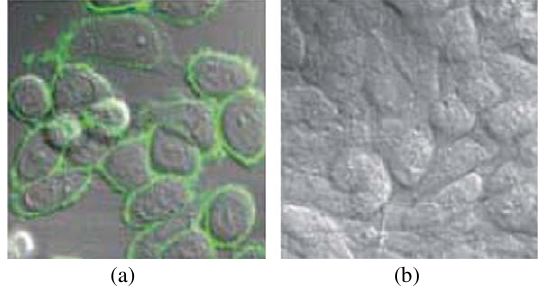
Fig. 7. Confocal microscopy studies show (a) binding of HER2- specific Affibody fluorescent probe with HER2 receptors in SKBR- 3. (b) No binding was observed between HER2-specific Affibody fluorescent probe and U251 cells (after